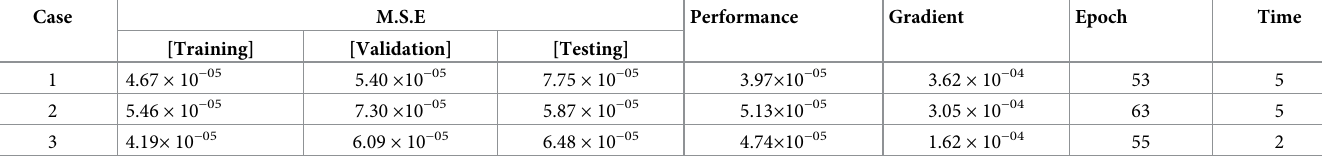
Table 1. Statistical procedures for solving the infection FONPPS using the proposed